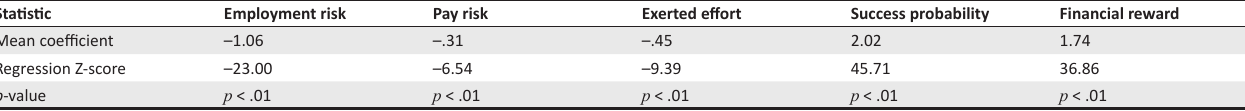
TABLE 2: Risk and reward attributes – Z-scores and significance of regression coefficients.